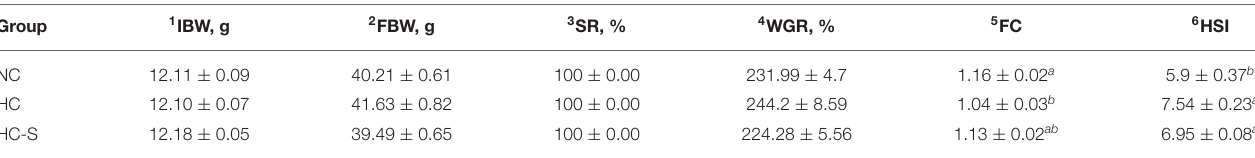
TABLE 2 | Effects of dietary SJ on growth performance and feed utilization swamp eel fed high-carbohydrate (HC) diet.